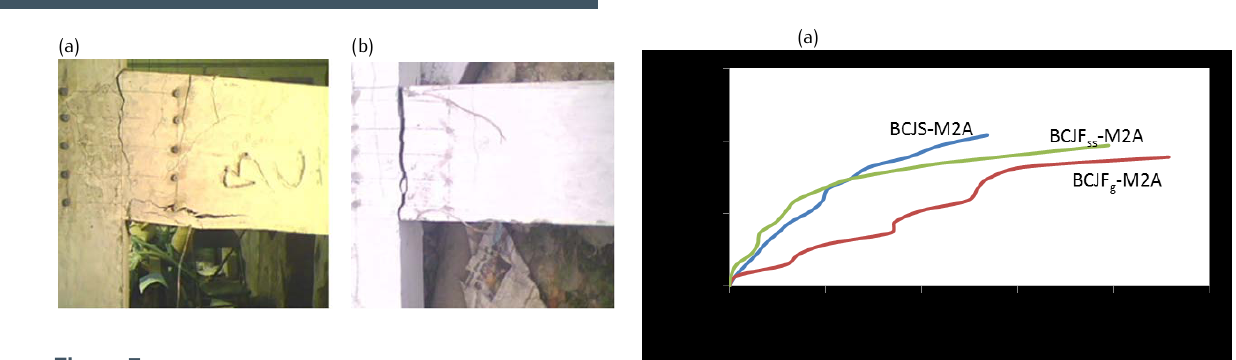
Figure 7. (a) Typical failure of control specimens; (b) Typical failure of GFRP specimens.